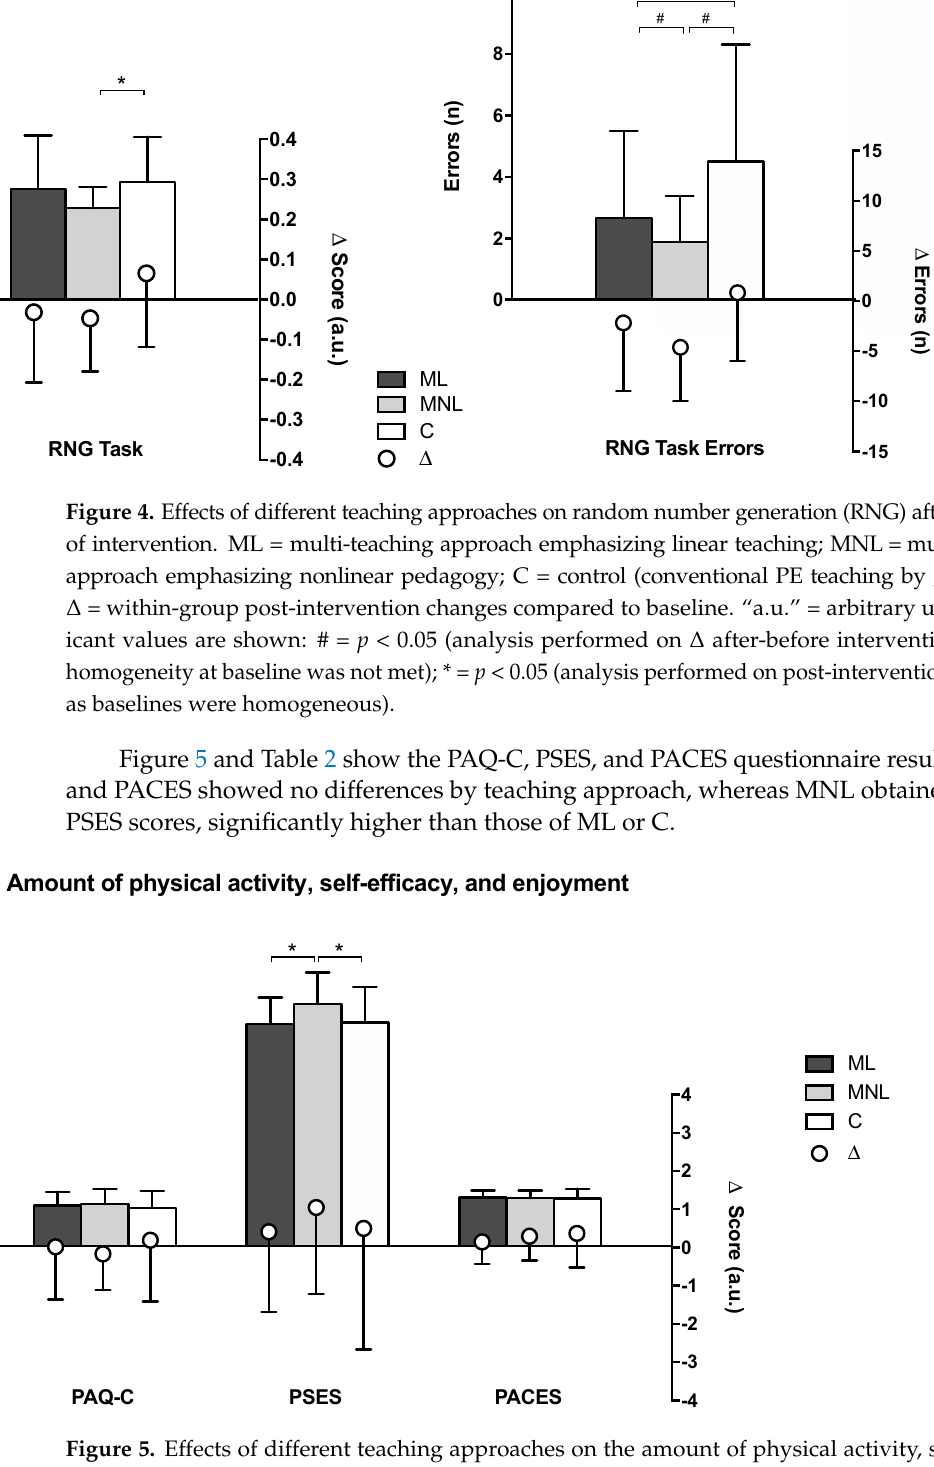
Figure 5. Effects of different teaching approaches on the amount of physical activity, self-efficacy, and enjoyment measured by questionnaires (PAQ-C, PSES, PACES) after 12 weeks of intervention. ML = multi-teaching approach emphasizing linear teaching; MNL = multi-teaching approach empha- sizing nonlinear pedagogy; C = control (conventional PE teaching by generalists); ∆ = within-group post-intervention changes from baseline. “a.u.” = arbitrary units. Significant values are shown: * = p < 0.05 (analysis performed on post-intervention measures because baselines were ho- mogeneous).